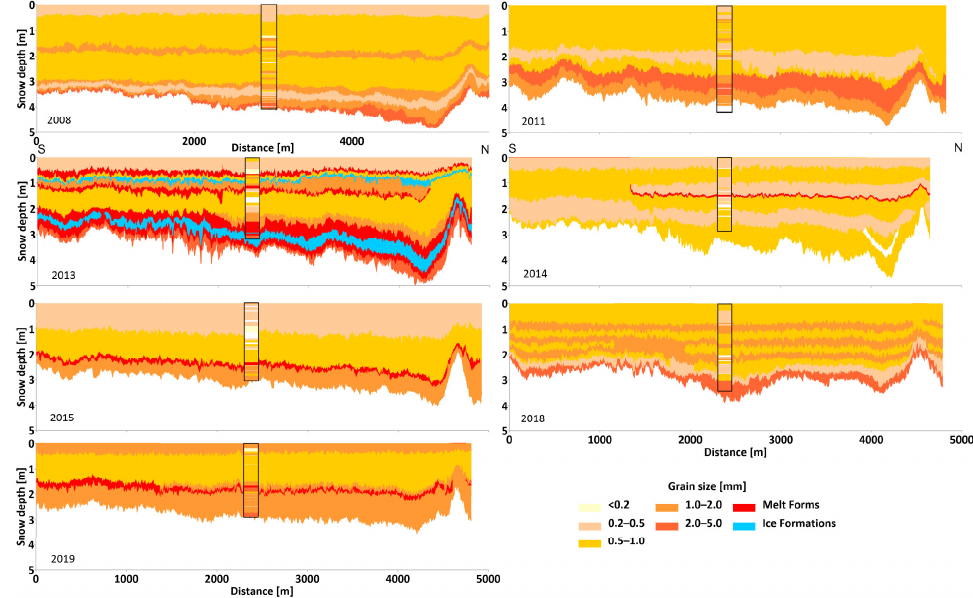
Figure 6. Grain size. Vertical rectangles in the middle of the GPR profiles denote HS and the grain size in the snow pits (H9). The white spaces represent undefined grain size. See the location of the GPR profiles on Figure 1.